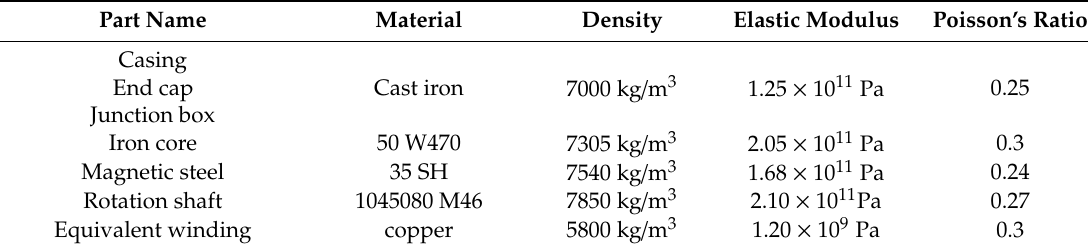
Figure 7. 3D finite element model of the motor and stator. ( a ) 3D finite element mesh of motor; ( b ) Equivalent winding; ( c ) Stator core. Table 3. Material parameters of every part of the motor.